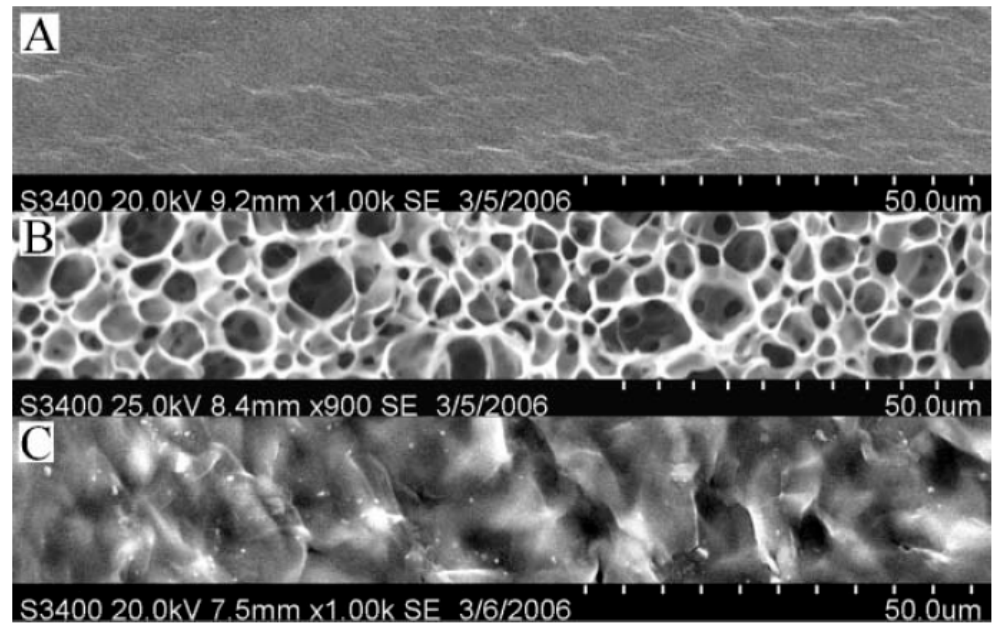
Figure 22. SEM images of polymers fabricated by microemulsion polymerization of MMA in the presence of the polymerizable ionic liquid-based surfactant-b. Parts ( A – C ) refer to polymer gel as produced, the gel after treatment with aqueous solutions of 0.1 mol L − 1 of KPF 6 and NaBr, respectively [227].